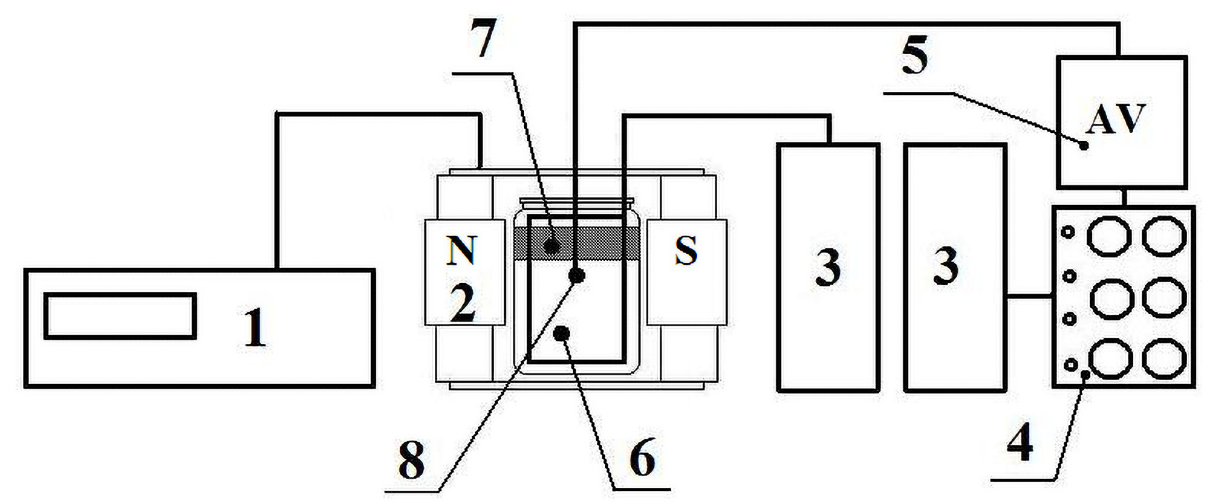
Fig 1. Scheme of the environment for experiments. 1 –a constant current source; 2 –magnetic coil; 3 –nickel-cadmium batteries; 4 –a resistance store; 5 –a voltammeter; 6 –an aluminum electrode; 7 –duckweed; 8 –a graphite electrode.